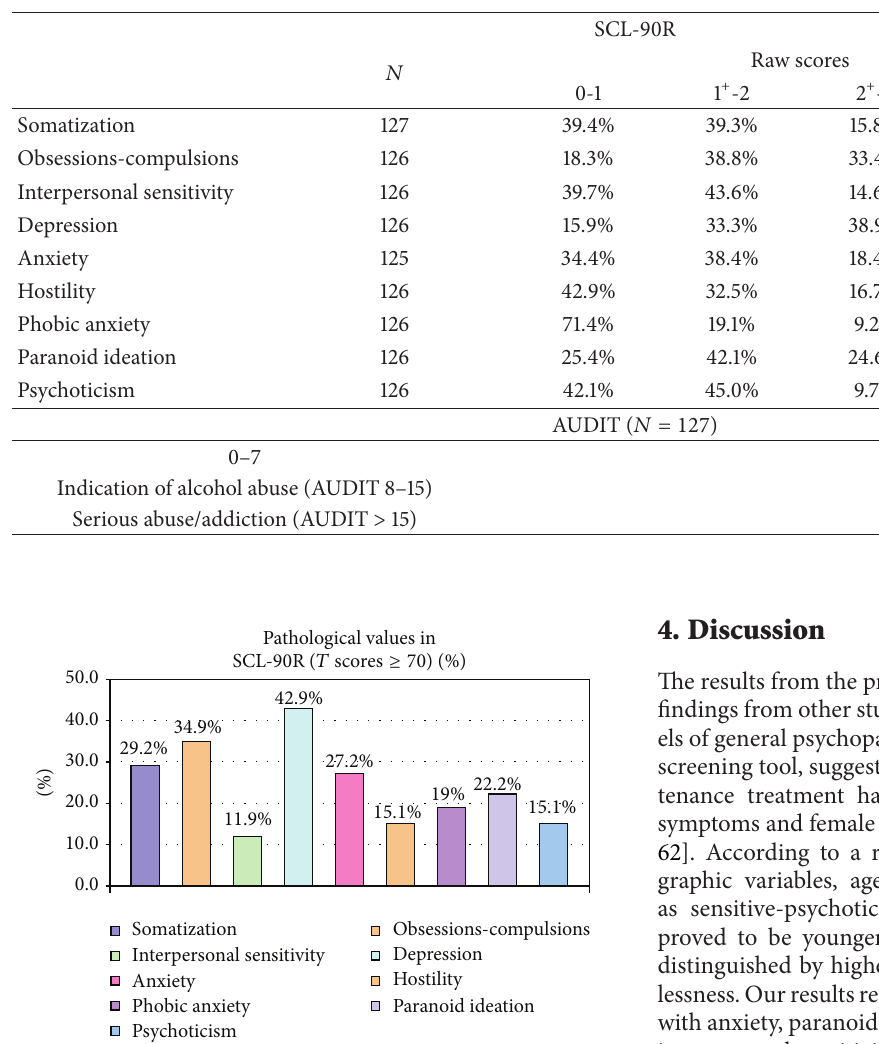
Table 2: Percentages of pathological values in SCL-90R and